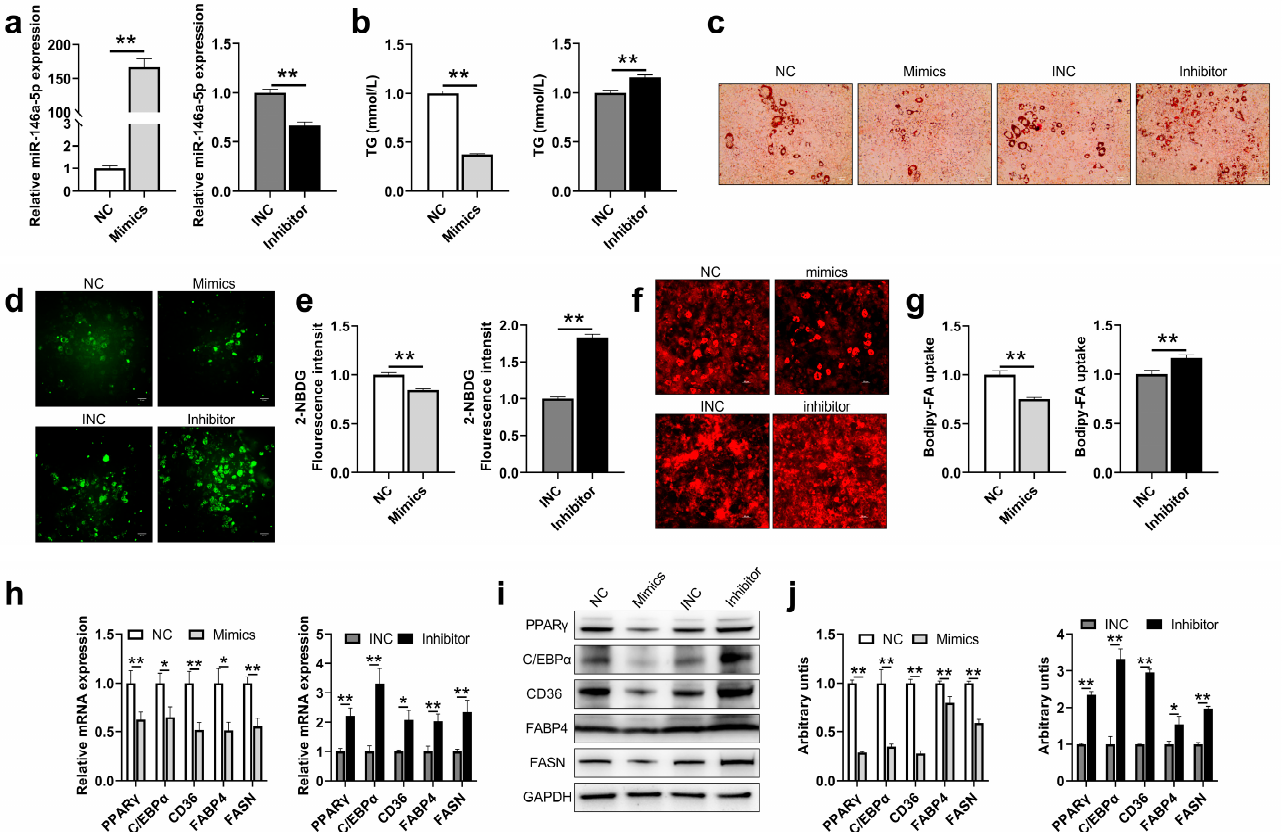
Figure 3. miR-146a-5p was associated with adipogenesis and glucose uptake and fatty acid absorption. ( a ) miR-146a-5p gene expressions in 3T3-L1 adipose mature cells after transfections of miR-146a-5p mimics (Mimics) and miR-146a-5p inhibitor (Inhibitor) (n = 6). ( b ) TG content in 3T3-L1 adipose mature cells after transfections of mimics and inhibitor (n = 6). ( c ) Oil red O staining photographs in 3T3-L1 adipose mature cells after transfections of mimics and inhibitor (scale bar = 50 µ m). ( d ) Fluorescence image of 3T3-L1 cells treated with glucose analog 2-NBDG for 1 h after transfections of mimics and inhibitor for 24 h (bar = 50 µ m). ( e ) Statistical graph of fluorescence value of 3T3-L1 cells treated with glucose analog 2-NBDG (n = 4). ( f ) Fluorescence image of 3T3-L1 cells treated with free fatty acid analog Bodipy-FA for 4 h after transfections of mimics and inhibitor for 24 h (bar = 50 μ m). ( g ) Statistical graph of fluorescence value of 3T3-L1 cells treated with free fatty acid analog Bodipy-FA (n = 4). ( h ) After transfection of mimics and inhibitor adipogenesis-related genes PPAR γ , C/EBP α , and fatty acid synthesis-related genes CD36, FABP4, and FASN were detected by real-time quantitative PCR in mature 3T3-L1 (n = 6). ( i , j ) After transfection of mimics and inhibitor, adipogenesis-related proteins PPAR γ , C/EBP α , and fatty acid synthesis-related proteins CD36, FABP4, and FASN were detected by Western Blot (n = 6). Values are presented as means ± SEM, * p < 0.05, and ** p < 0.01, according to the non-paired Student’s t-test or one-way ANOVA between individual groups.